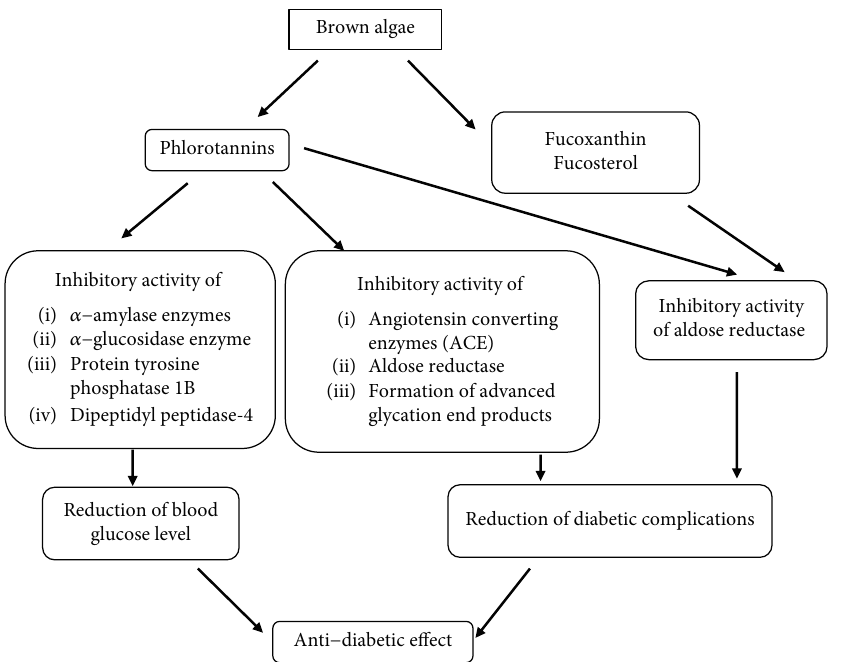
Figure 5: Di ff erent antidiabetic mechanisms of active agents of brown